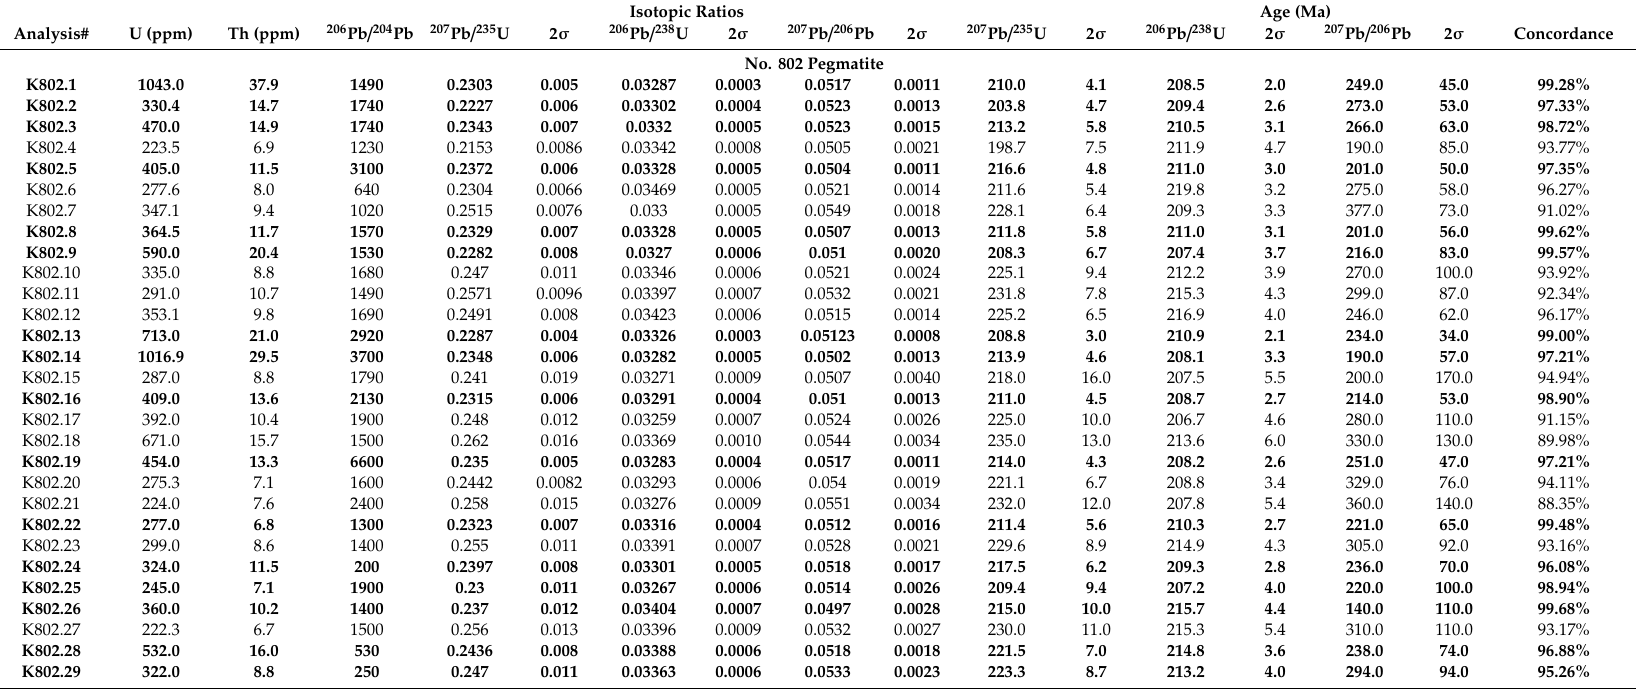
Table 3. Results of columbite LA-ICP-MS (laser ablation-inductively coupled plasma mass spectrometer) dating for the Kalu’an Li-rich